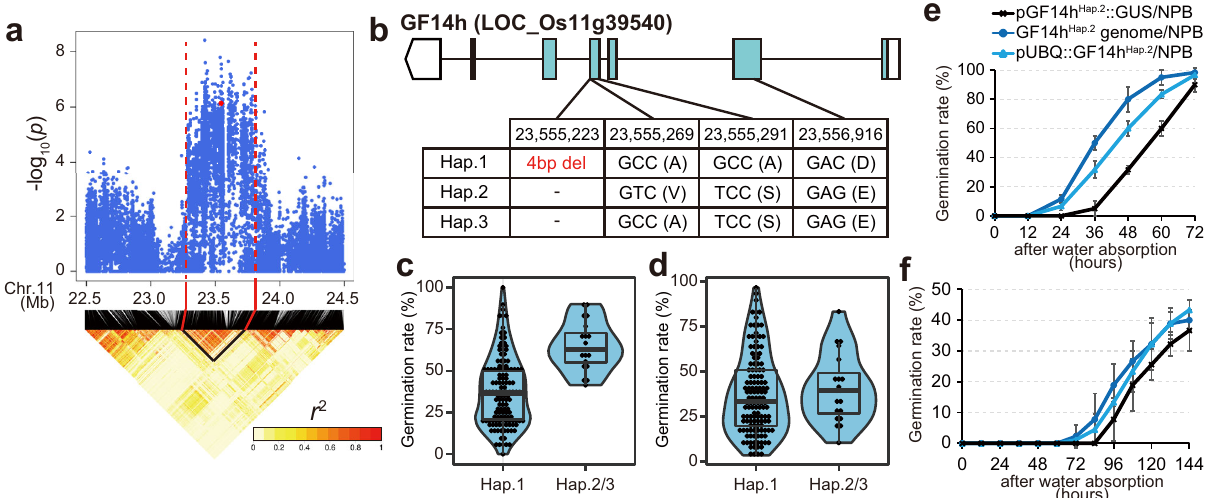
Fig. 2 | Identi fi cation ofthe causal gene for G × E Peak1. a Local Manhattanplot (top) and LD heatmap (bottom) surrounding Peak 1. Red dashed lines indicate the close up ofPeak1 regionshown inFig. 1d,andthe red dotindicatestheposition of the 4bp InDel variation in GF14h. b Exon-intron structure of GF14h with poly- morphisms inducing amino acid exchanges. Violin plots showing germination rate of cultivars that have loss-of-function (haplotype [Hap.]1) and gain-of-function (Hap.2/3)at30°Cfor24h( c )and15°Cfor96h( d ).Haplotypeinformationisshown